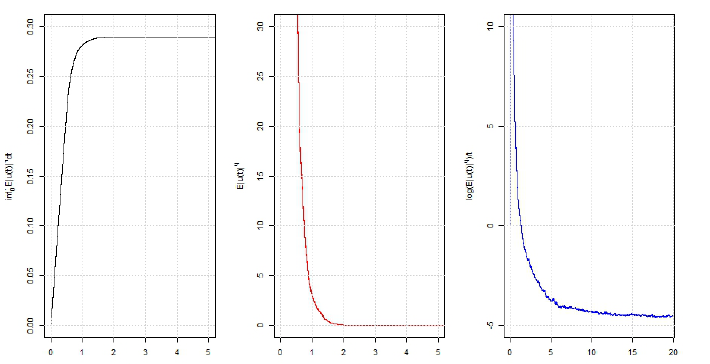
(cid:82) t E | u ( t ) | 2.1 d t , E | u ( t ) | 2.1 , log ( E | u ( t ) | 2.1 ) / t for system (23) with c = 0 and sample size 200. Figure 3. 0 When c = 2, it is also shown that DDE (22) is asymptotically bounded (see Figure 4). For q = 2.1, (cid:52) = 0.65, and β = 0.0001, we can take parameters h 0 , h 1 with h 0 + h 1 = 0.035, c 15 = 1, such that conditions (16)–(18) hold. Calculations yield that γ 4 = 0.9003872, γ 5